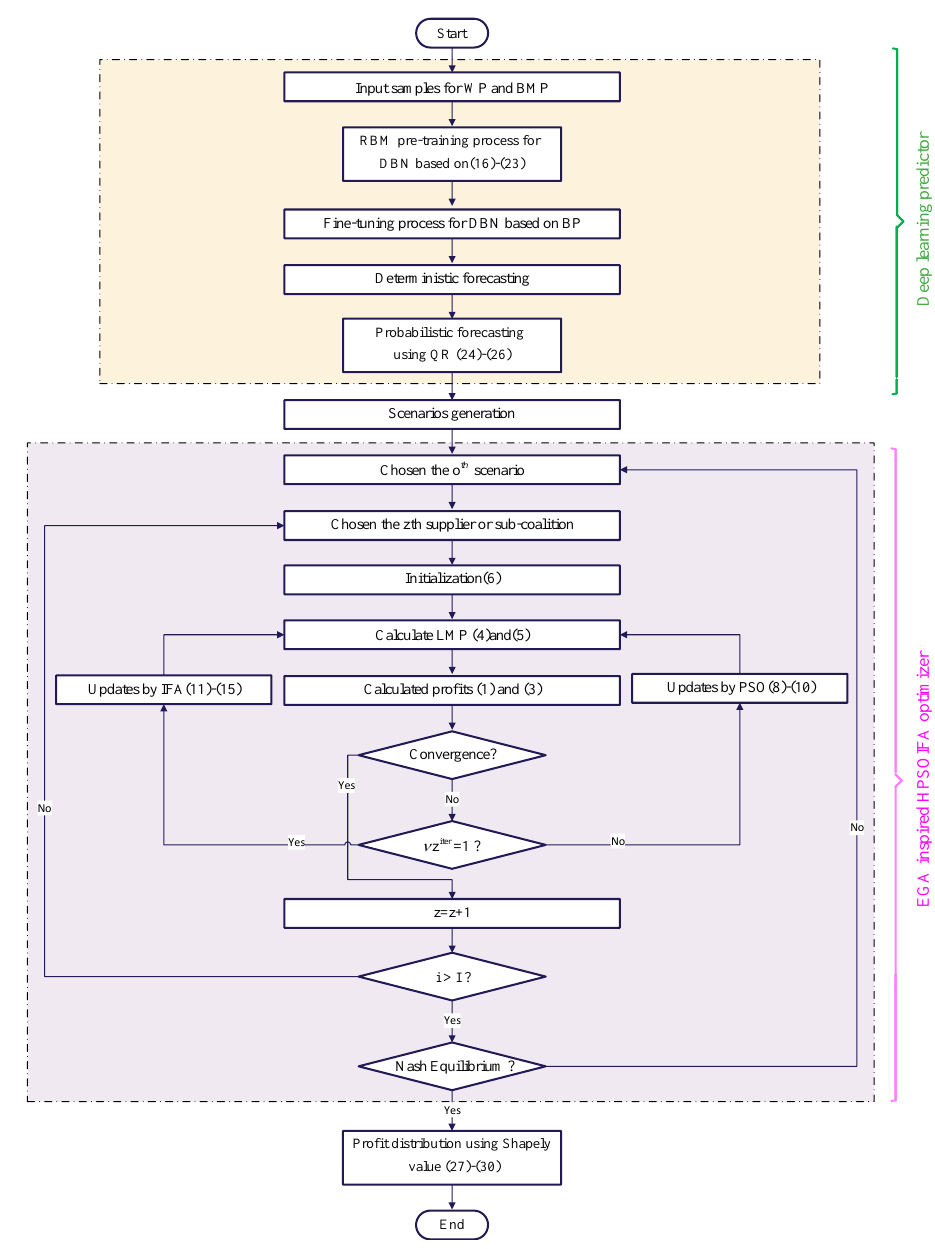
Figure 3. Flowchart of the wind energy suppliers’ market bidding